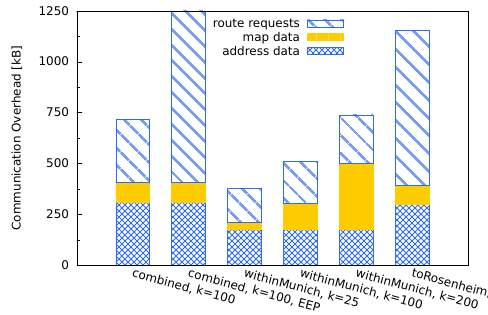
Figure 10: Mean communication cost using R5r